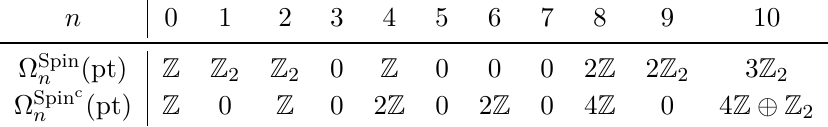
Table 1 . Spin and Spin c cobordism groups of the point up to n = 10 .